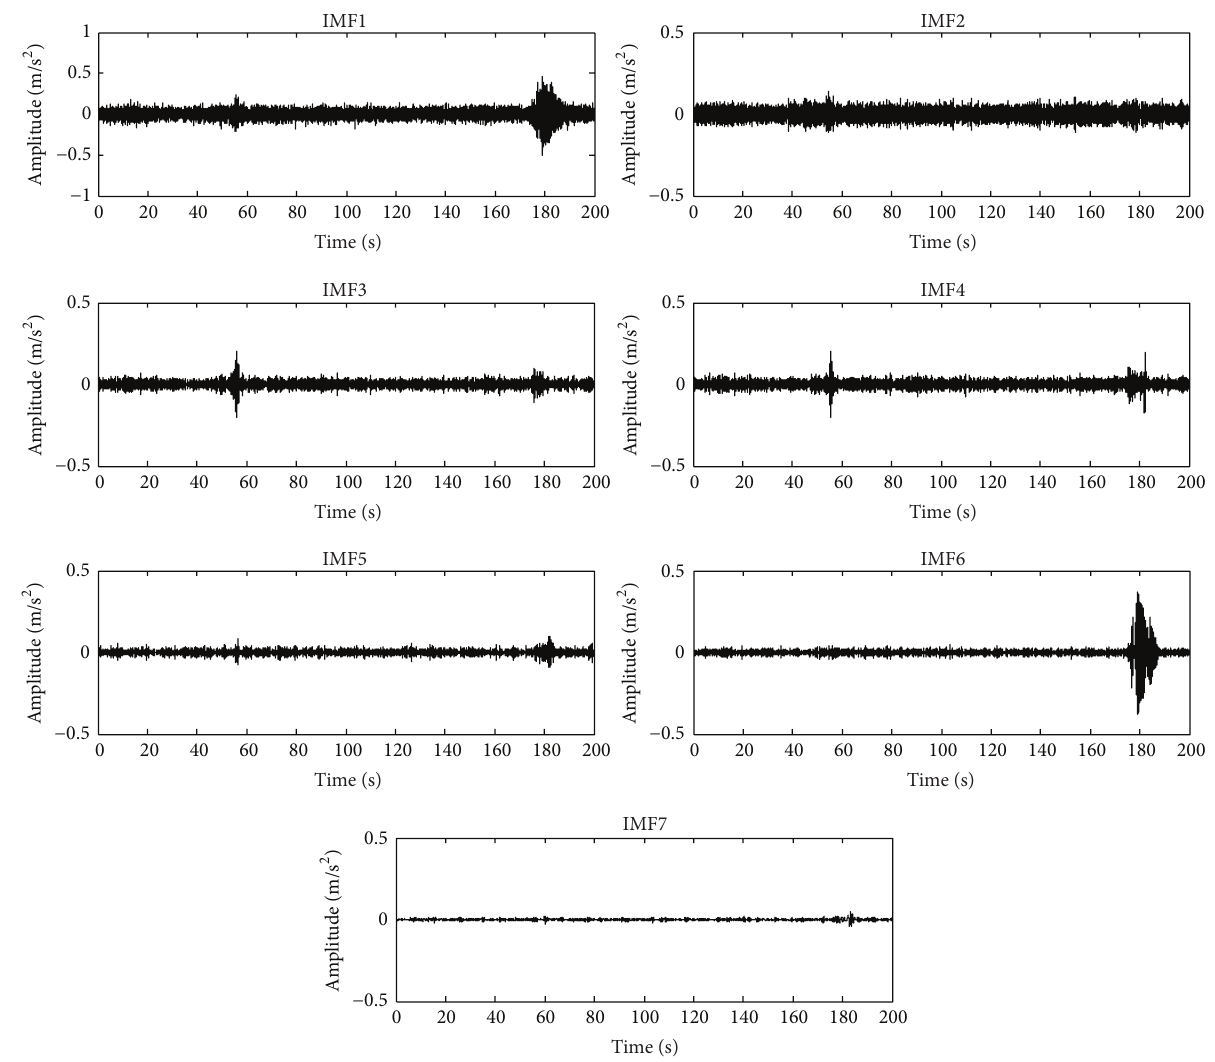
Figure 11: IMFs obtained through EEMD for ambient vibration acceleration.